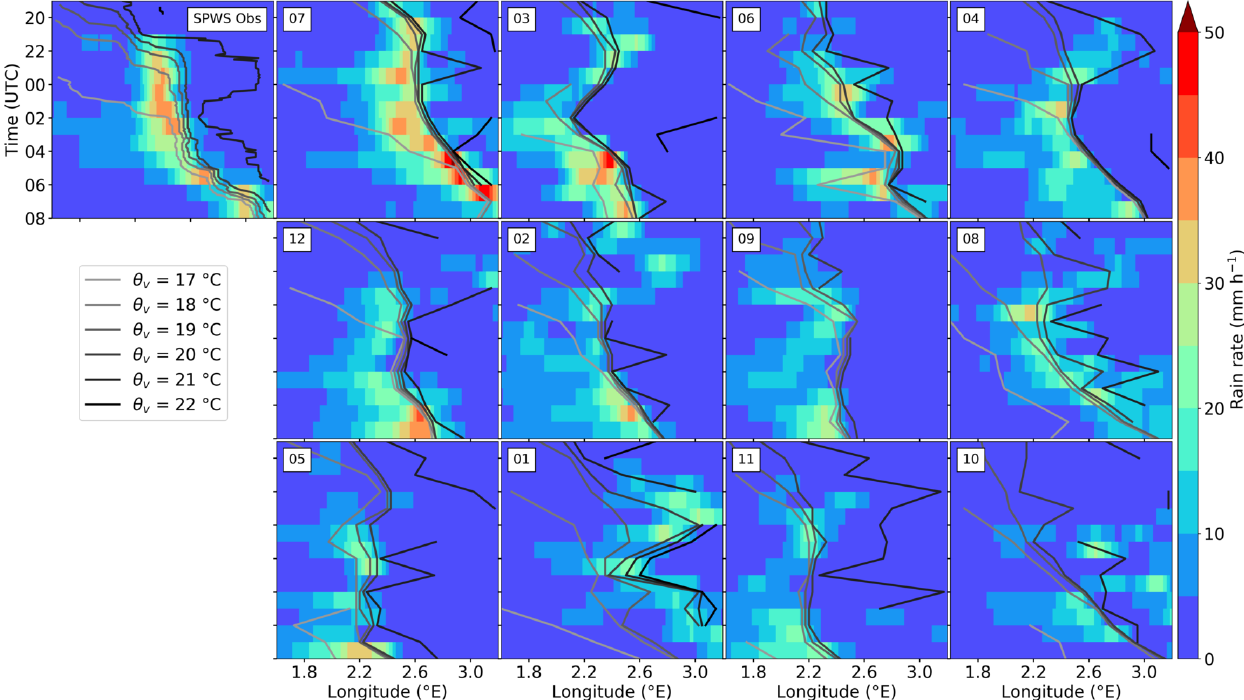
Figure 18. As in Fig. 16 showing the mean longitude of the 17, 18, 19, 20, 21 and 22 ◦ C 2m virtual potential temperature